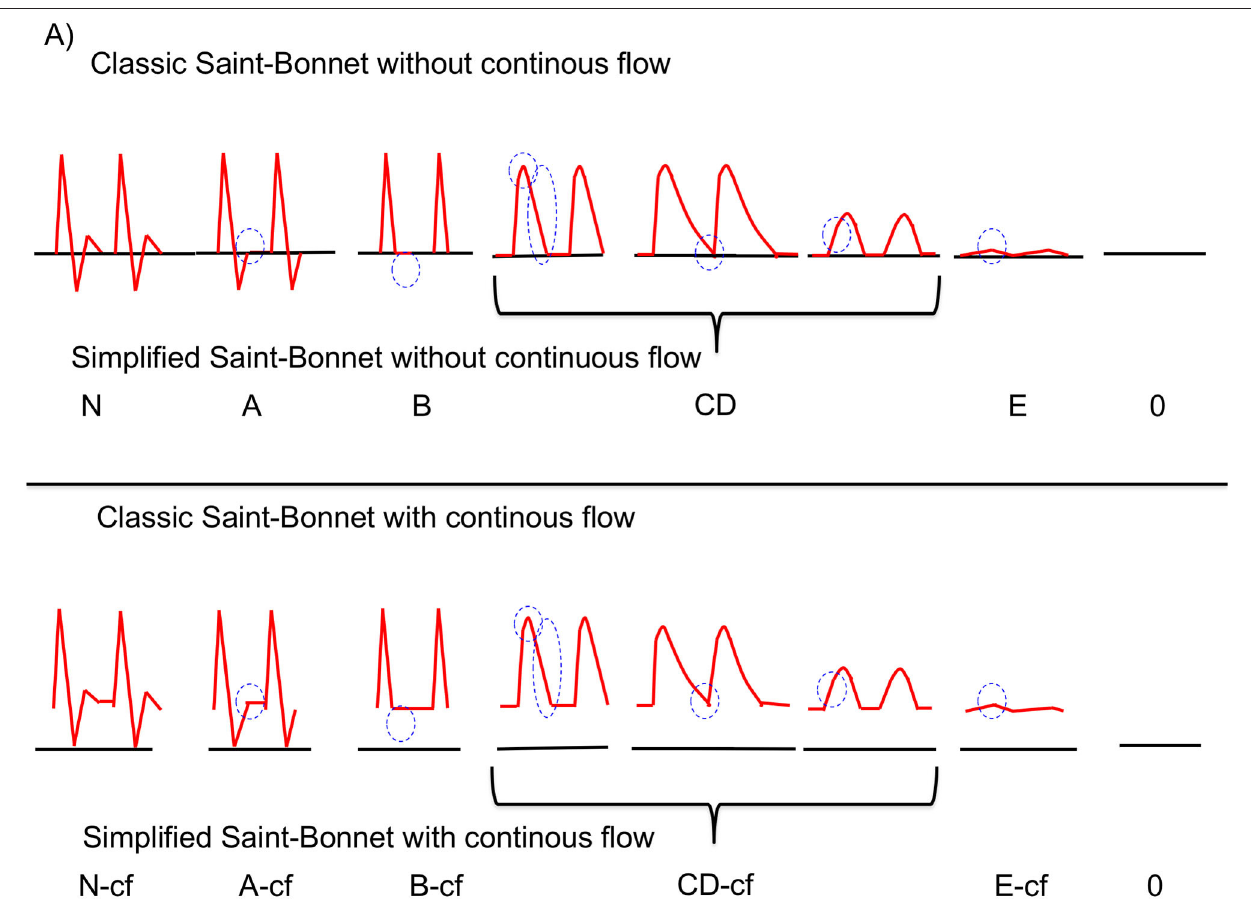
FIGURE 1 | Simplified Saint-Bonnet Classification. Saint-Bonnet classification according to arterial lesion severity (from type N to 0). cf, continuous flow. The blue circles represent the key elements that vary from type to type. Of note: continuous flow may be horizontal or slightly descending. This diagram shows stable continuous flow and is therefore depicted horizontally. For more information please refer to initial Vasa publication (13).